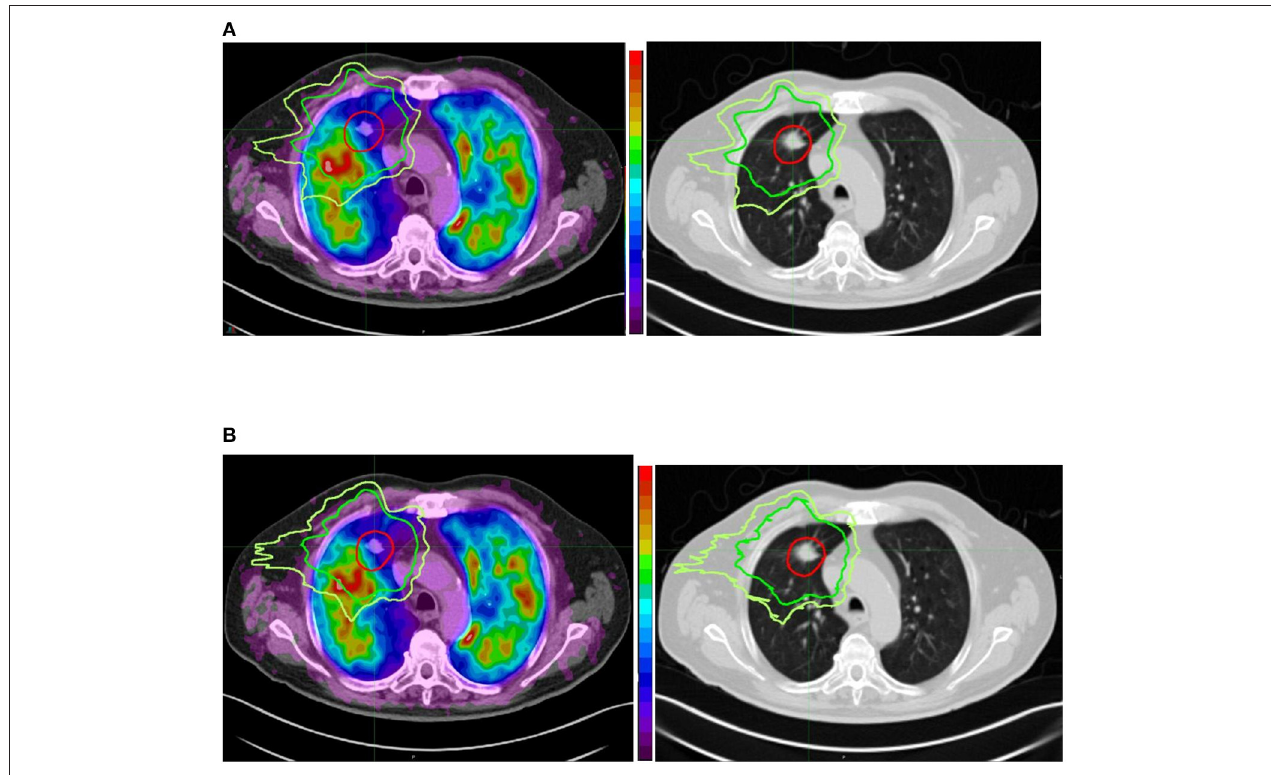
FIGURE 1 | Comparison between conventional (anatomically based) planning (A) and functional lung avoidance planning guided by 68 Ga Q PET/CT (B) in a patient treated for a lung tumor by stereotactic body radiation therapy. Both planning show optimal coverage (red isodose line) of the tumor but the functional planning shows a decrease of the dose (20Gy isodose in green and 16Gy isodose in yellow) to the functional lung (in red the most functional areas and in blue the least functional areas). We can also see that on the corresponding anatomical images we cannot see any difference between the functional and non-functional